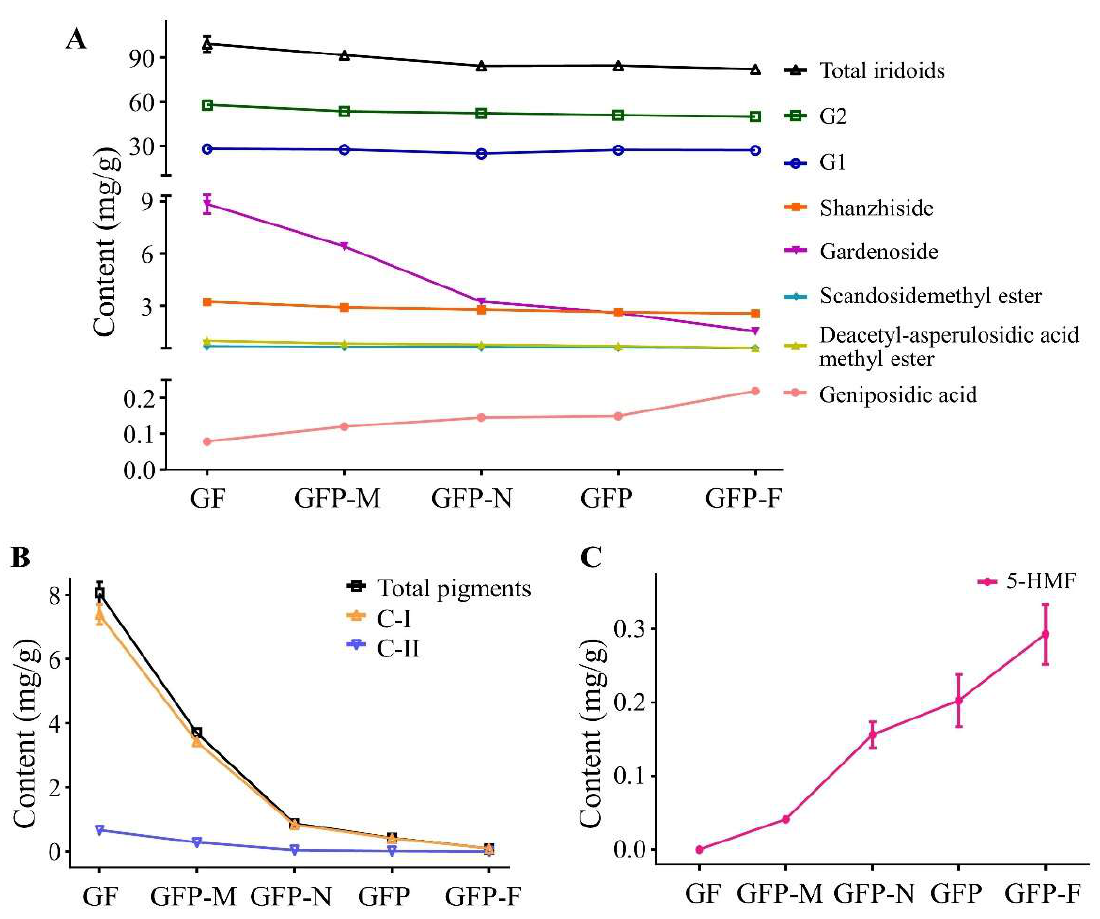
Figure 2. The changed contents of 10 compounds of GF (pre-processed pieces), GFP-M (middle- processed pieces), GFP-N (near-processed pieces), GFP (the right processed product) and GFP-F (far-processed pieces). ( A ) Iridoids; ( B ) Pigments; ( C ) 5-HMF.